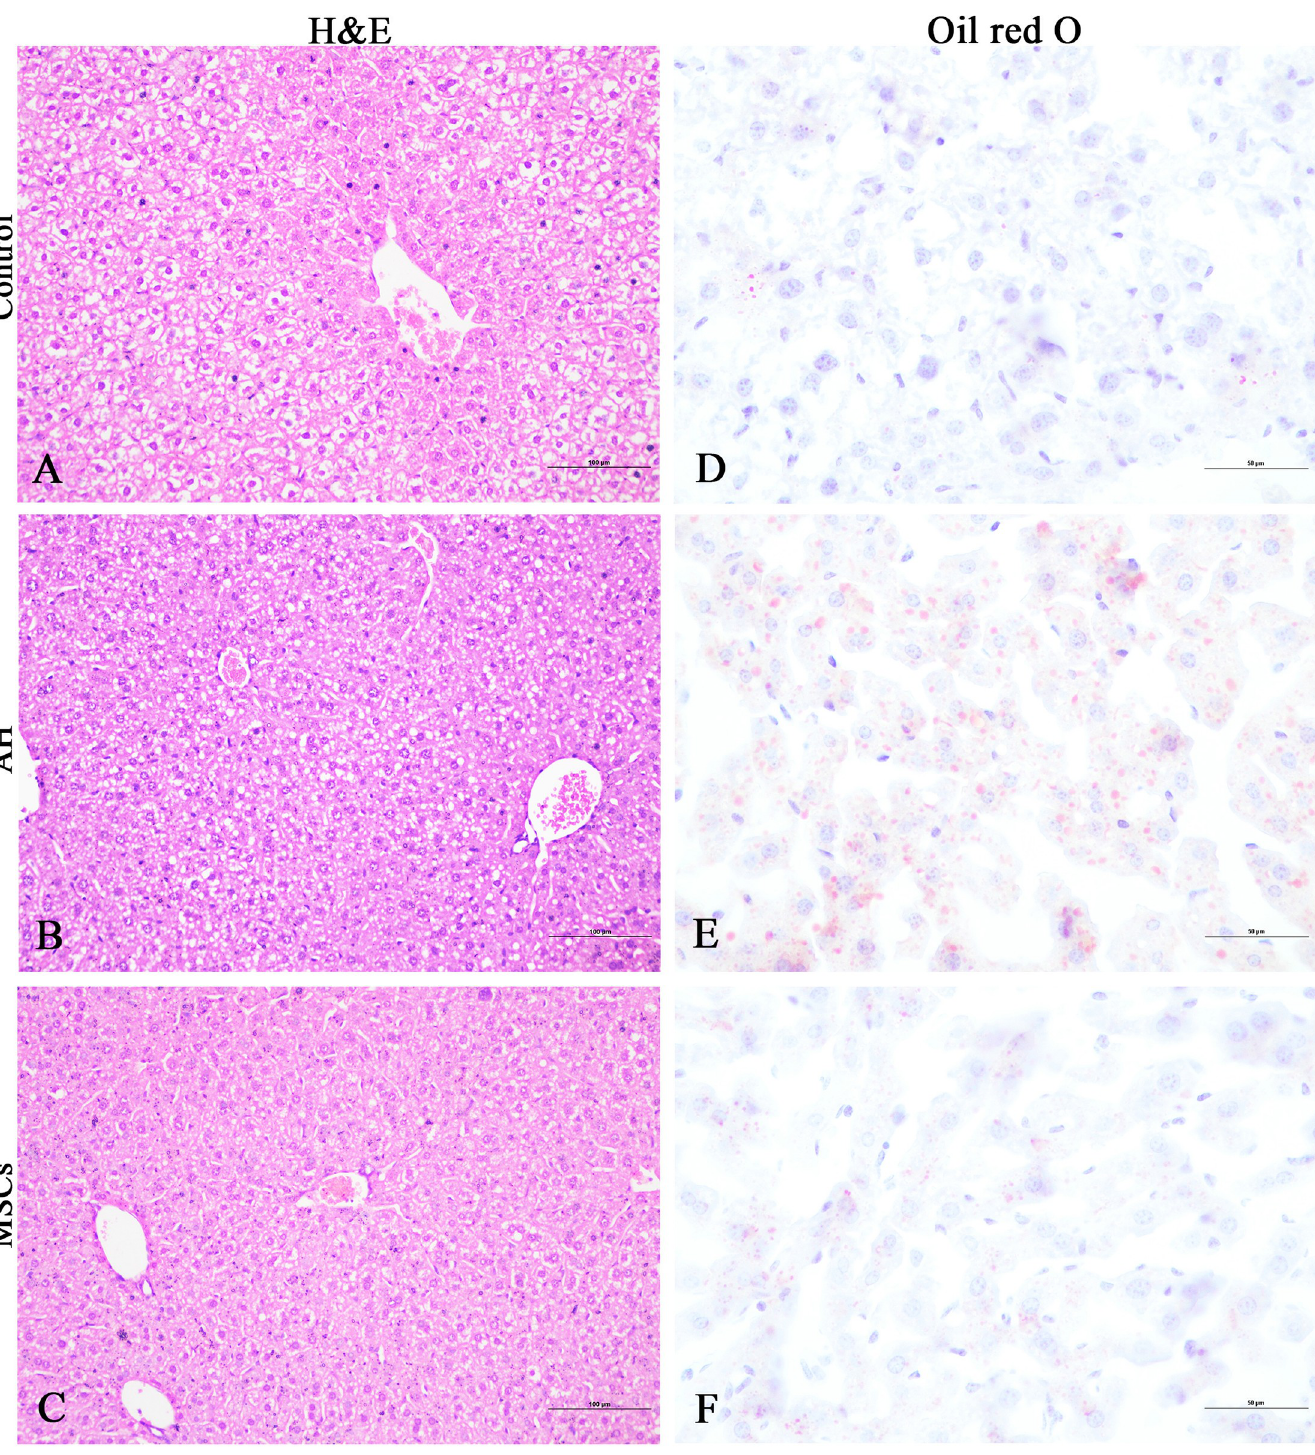
PLOS ONE | https://doi.org/10.1371/journal.pone.0228889 February 11,